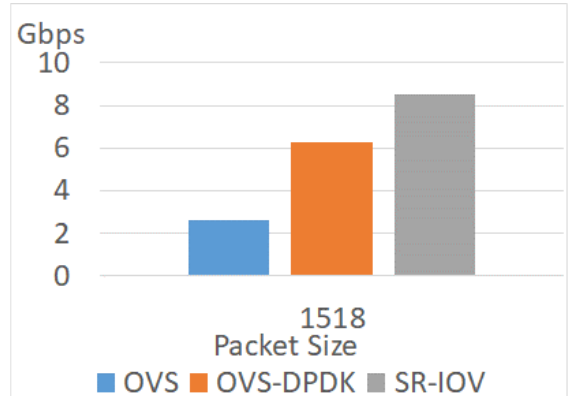
Figure 17. Throughput of different technologies in PVVP scenario when packet size is 1518.